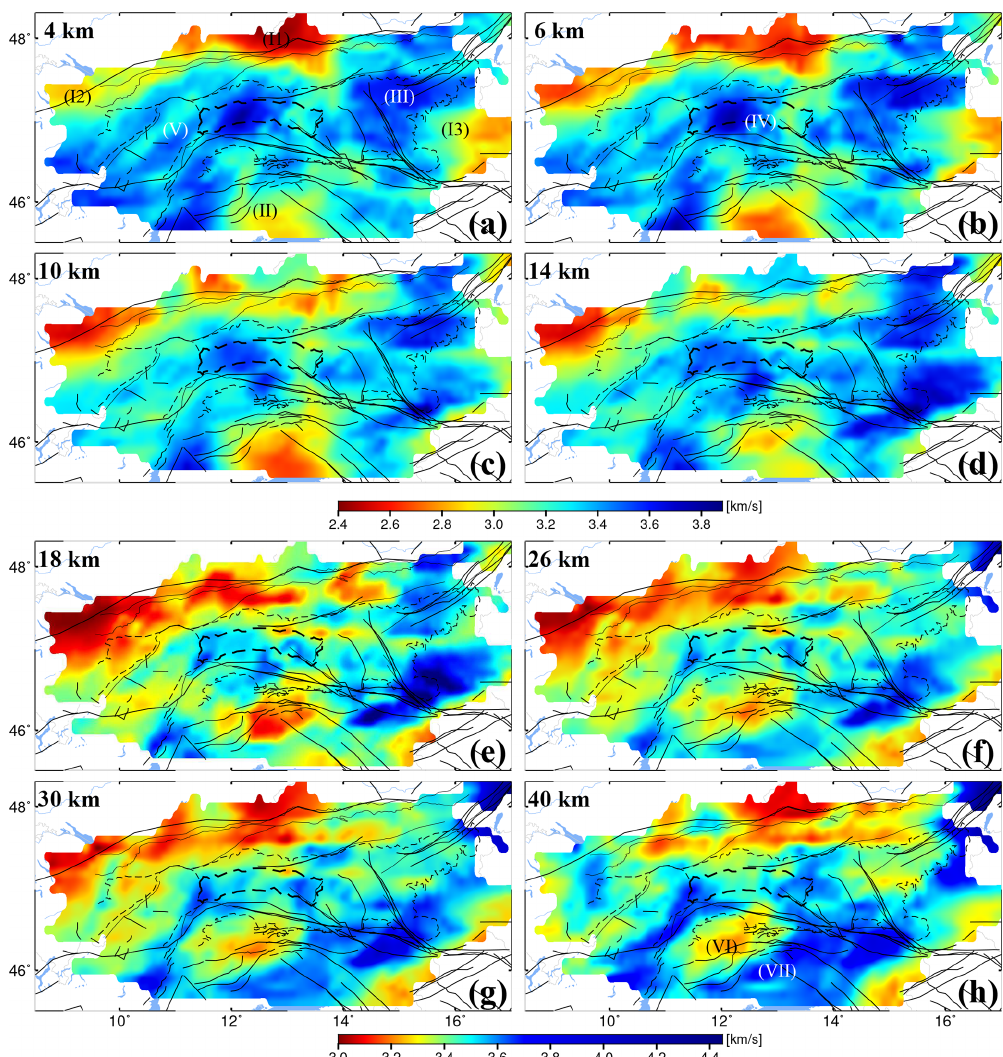
Figure 12. Shear velocity model derived from inversion of the Love-wave group velocity maps. Solid and dashed black lines are as in the previous figure. See the text for the velocity anomalies marked by Roman